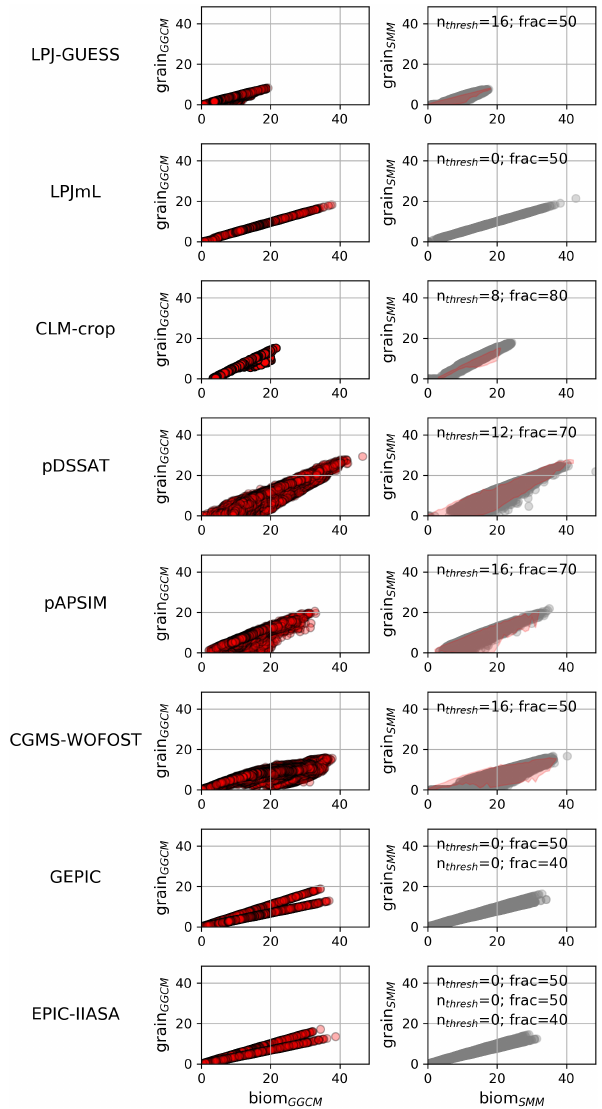
Figure 7. Relationship between grain and biom: comparison be- tween GGCM and SMM after its calibration. The grain vs. biom relationship for GGCMs (left column) and for SMM after indepen- dent calibration against each GGCM (right column) are both dis- played. For SMM, the relationship is given for the ( n thresh , frac) combination that maximizes the match between GGCM and SMM (see Sect. 2.2.4). The calibrated combination is given at the top of each SMM panel. When multiple cultivars are considered, one cali- brated ( n thresh , frac) combination is given per cultivar. In the right- hand panels, pink shading defines A GGCM (see Sect.